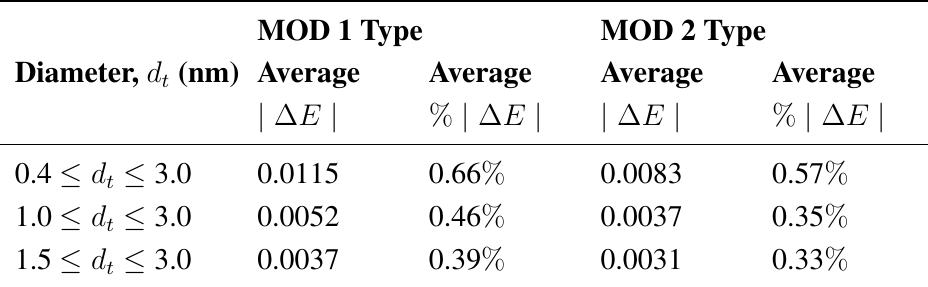
Table 2. Comparison of experimental and empirical data of E error and % average